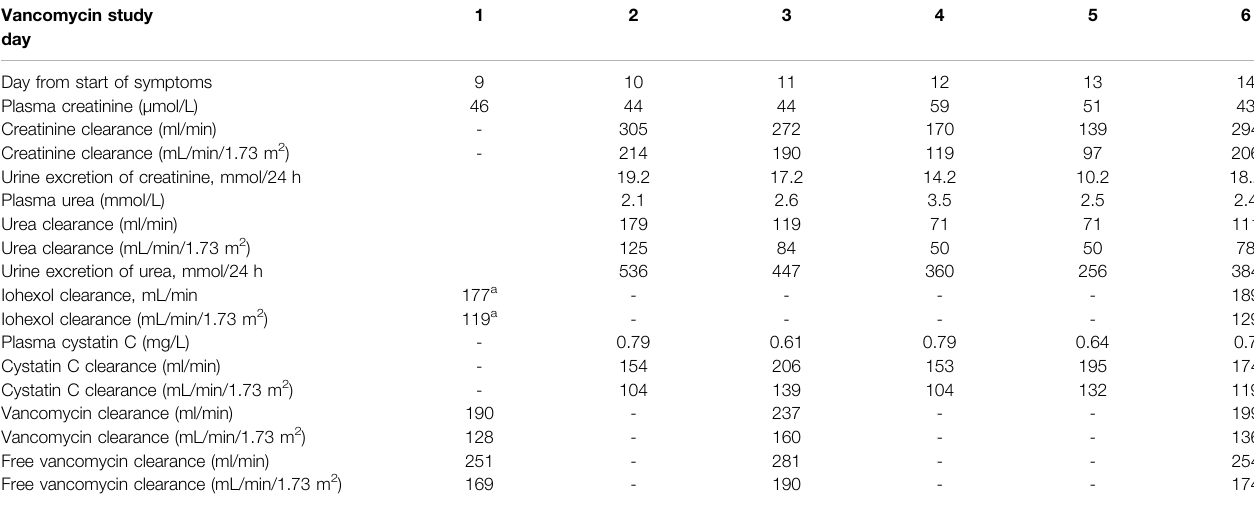
TABLE 3 | Creatinine, urea, iohexol, cystatin C, and vancomycin (total and free) clearances together with plasma concentrations of creatinine, urea, and cystatin C and excretion of creatinine and urea during the 6 days of clearance